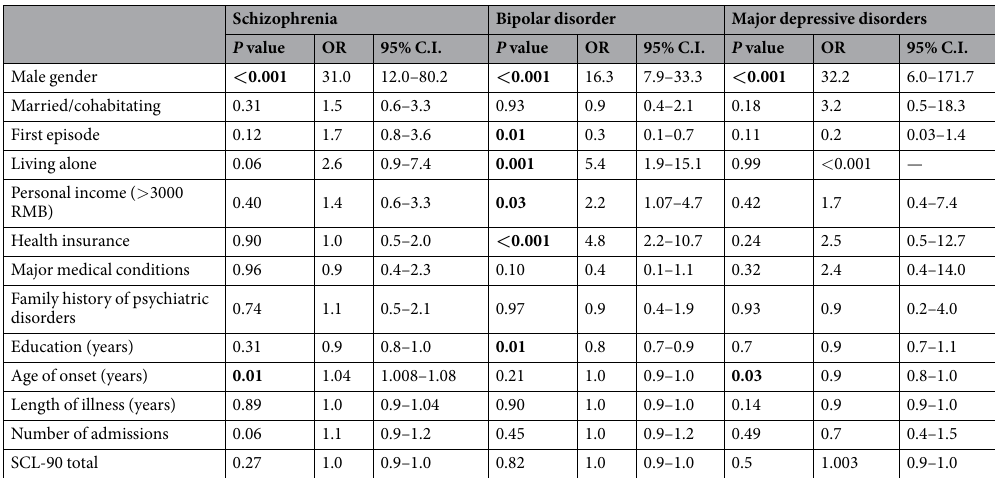
Table 3. Demographic and clinical correlates independently associated with smoking by diagnoses. Bolded values: < 0.05; SCL-90 = Symptom Checklist-90; SF-12 = Medical Outcomes Study Short Form; OR = Odds ratio; Due to collinearity between age and age of onset in schizophrenia, between age and age of onset and length of illness in bipolar disorder and between age and age of onset and length of illness in major depressive disorders, age was not entered as independent variable in the above multiple logistic regression